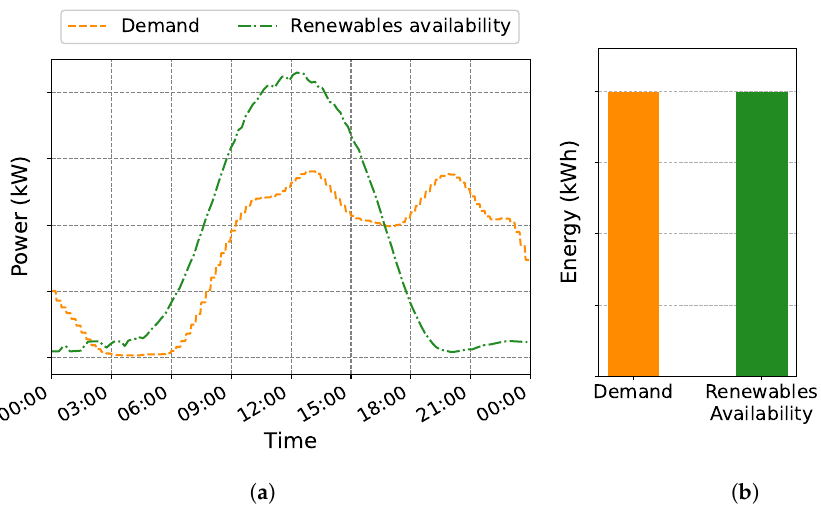
Figure 1. Peak power increase due to V2G. ( a ) Power demand and availability. ( b ) Energy demand and